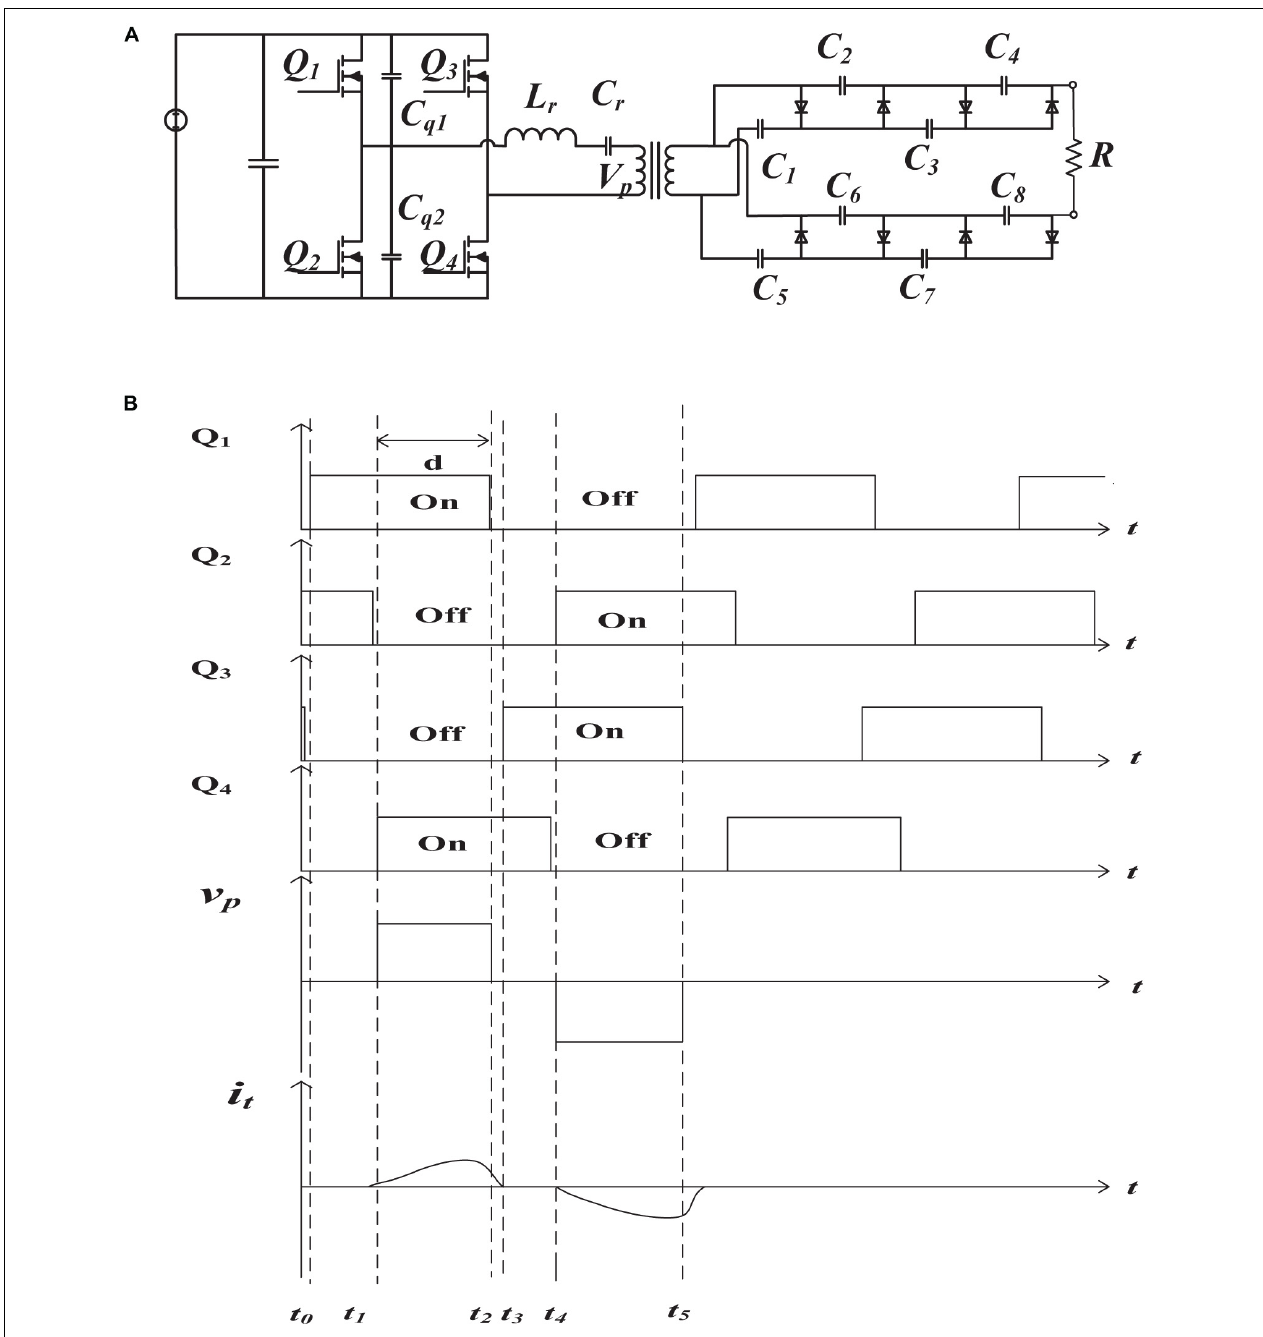
FIGURE 12 | Improved space high-voltage power module. (A) Improved circuit. (B) Switch state and transformer